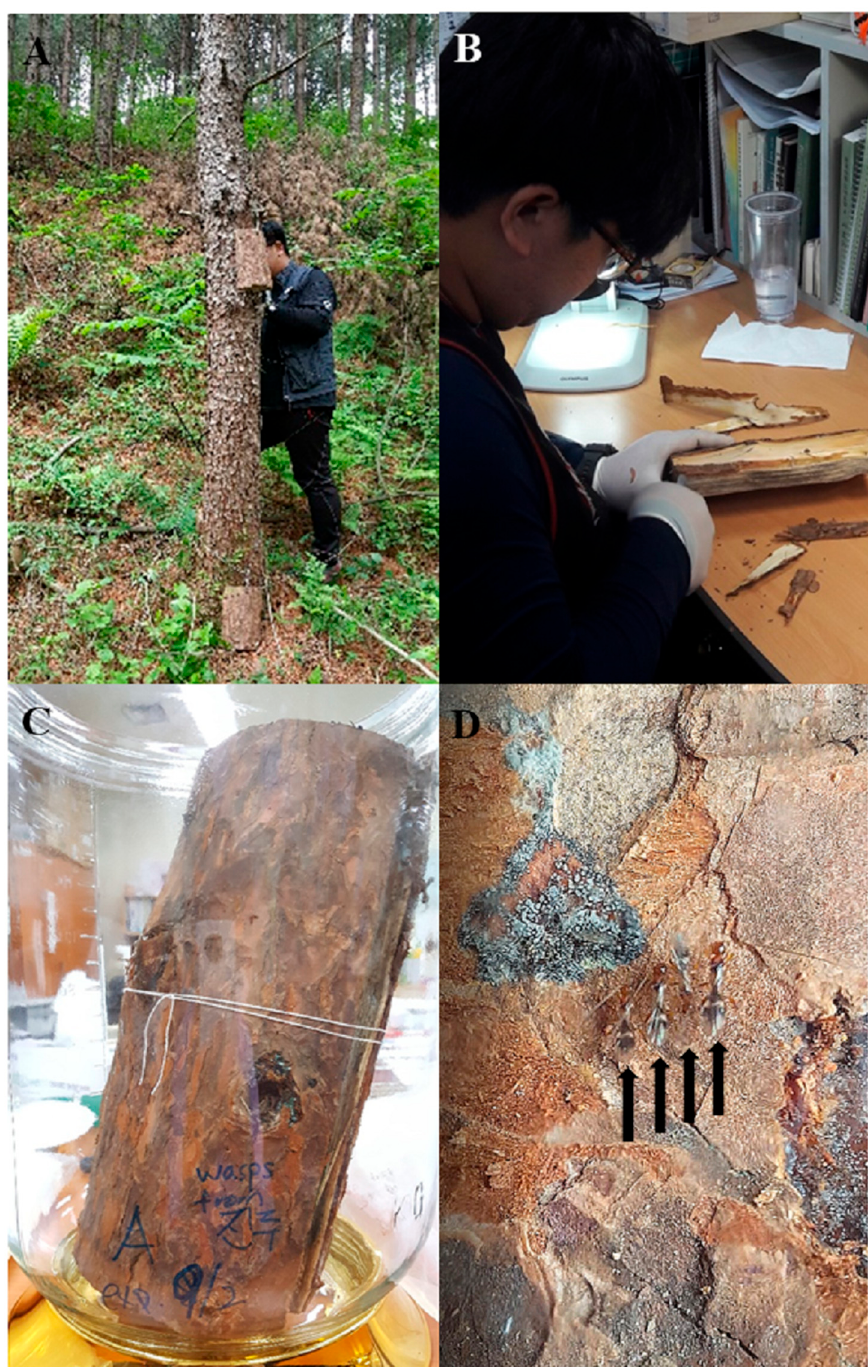
Figure 2. Sampling parasitoids of a vector with a sentinel log of Monochamus sp. and indoor oviposition observation setup for Spathius verustus : ( A ) hanging two sentinel logs at two different heights (0 m and 1.8 m) from the base of a pine tree; ( B ) peeling off the bark of the collected sentinel logs after 14-day exposure to find parasitoid larvae. ( C ) A whole sentinel log with S. verustus in a glass cage. ( D ) Four females (black arrows) gathered in one place, drilling for oviposition.